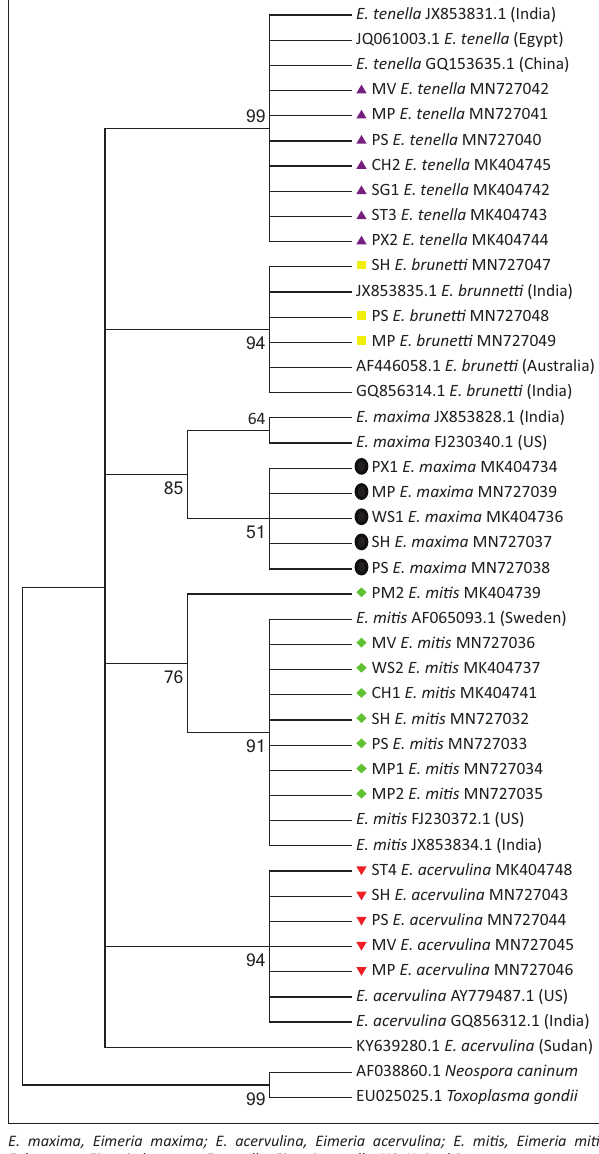
FIGURE 5: Maximum likelihood tree (Tamura-3 model) of internal transcribed spacer-1 sequences of Eimeria species. Percentage of bootstrap (1000 replicate) values is indicated in each node. The scale bar indicates sequence substitution per site. Sequences in this study are in different colours and